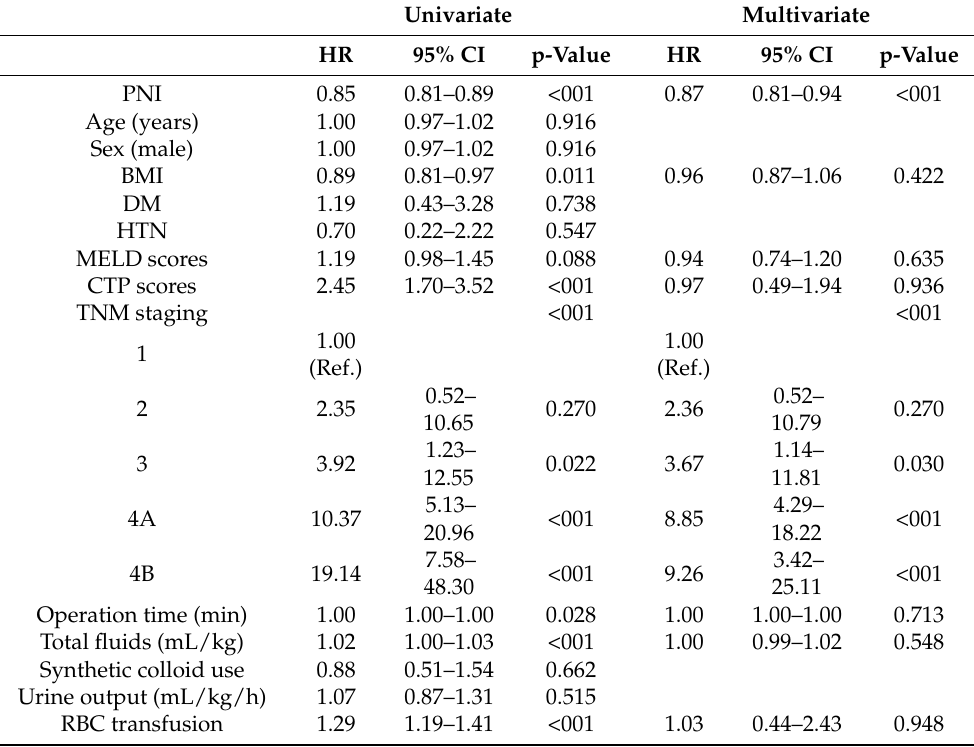
Table 3. Cox regression analyses of one-year mortality.